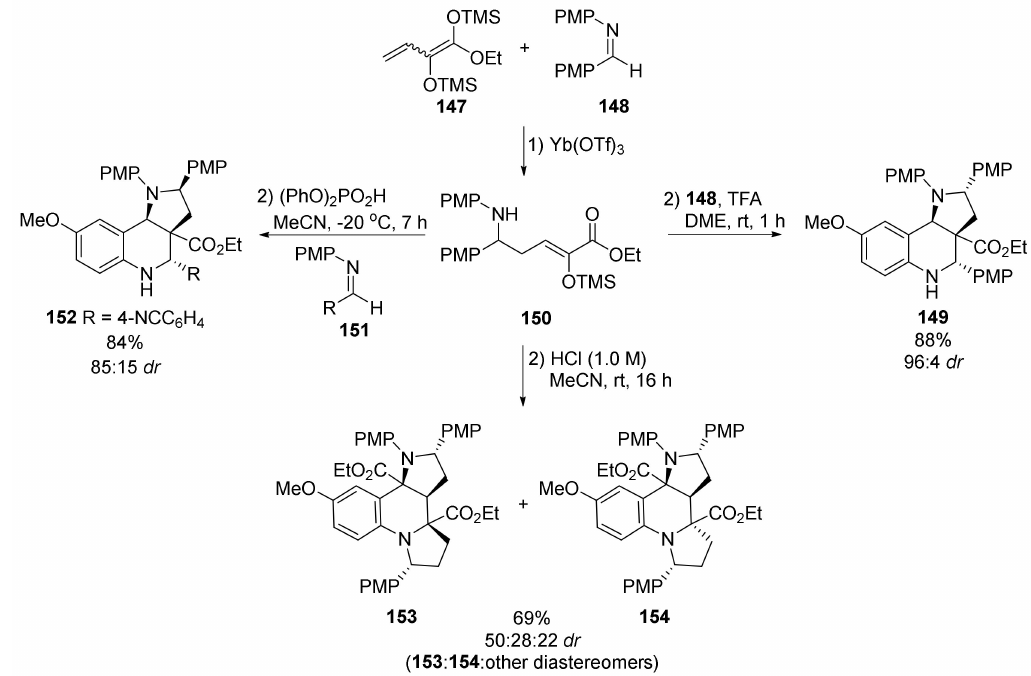
Scheme 24. Synthesis of the pyrroloquinoline and the dipyrroloquinoline scaffolds by Schneider and co-workers. Bakthadoss and co-workers obtained the martinella scaffold from Bayliss Hillman derivatives via a 1,3-dipolar cycloaddition [83]. N -tosyl- N -allyl-2-aminobenzaldehyde ( 155 ) was treated with N -methyl glycine ( 156 ) to form pyrroloquinoline 157 in 94% yield through imine formation and decarboxylation followed by a 1,3-dipolar cyclization reaction (Scheme 25).